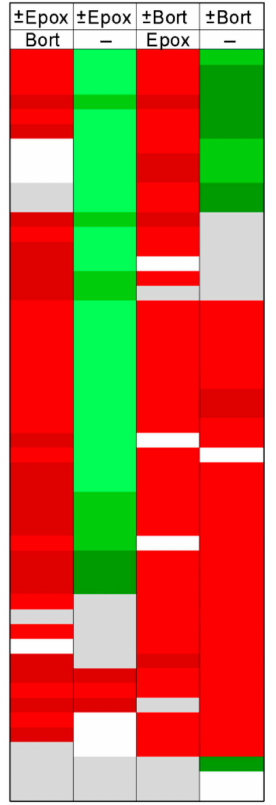
Figure 5. Heat map analysis of selected peptides. Peptides commonly detected in most experiments were selected for this analysis. Each row denotes a specific peptide, and each column represents a di ff erent experiment described in Figure 4. Peak intensities of peptides found with multiple charge states and / or numbers of tags were summed and expressed as a ratio of average control such that a single value for the peptide ratio could be obtained for each replicate. The ratio was color-coded using the scheme shown in Figure 2, with green representing decreases and red representing increases. Grey represents peptides that did not change substantially. White corresponds to peptides that were either not detected or which could not be accurately quantified due to peak overlap with another co-eluting peptide. Names of protein precursors, peptide sequences, mass, cleavage sites, and peptide ratios are provided in Table